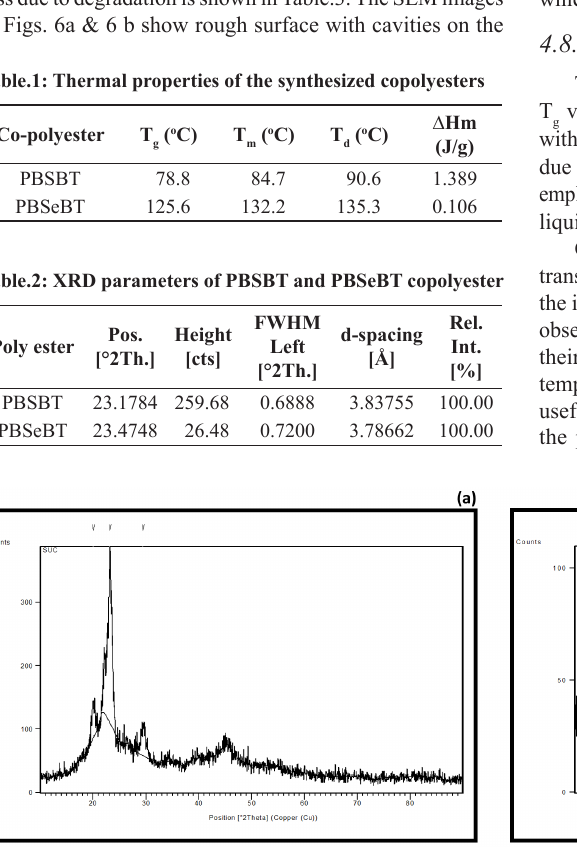
Fig.5a. X-Ray Thermogram of PBSBT copolyester; b. X-Ray Thermogram of PBSeBT copolyester